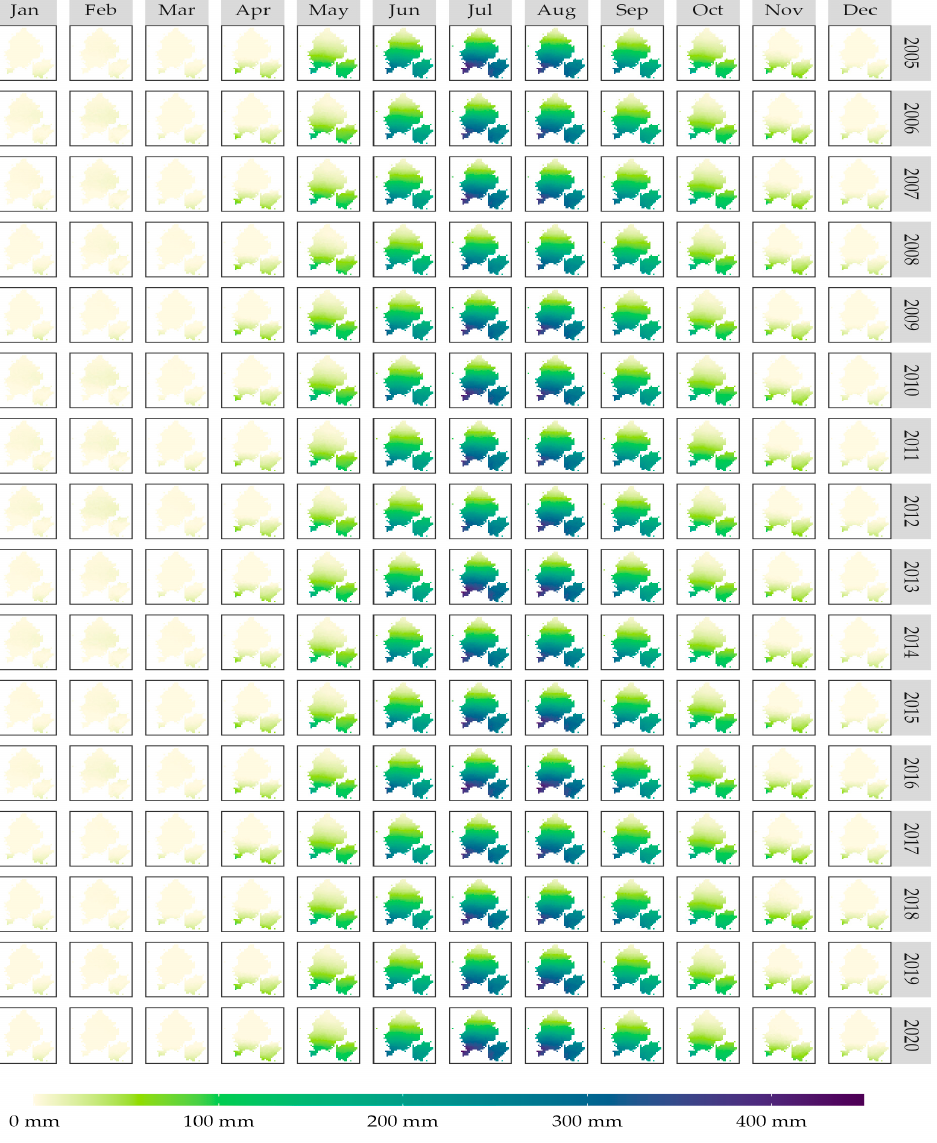
Figure 5. Spatial-seasonal distribution of rainfall forecast with the polynomial model, sample from the years 2005 to 2020.